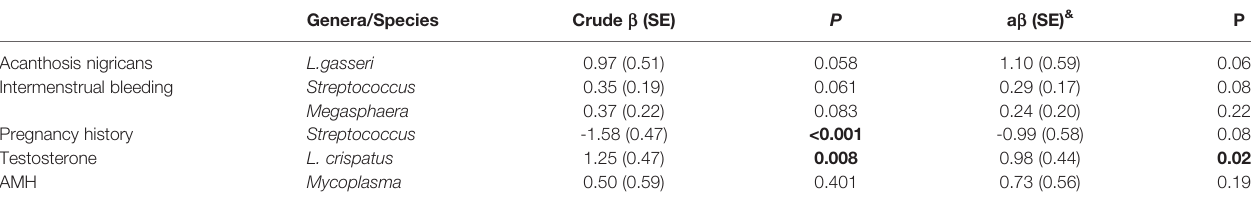
TABLE 4 | Potential biomarker constituents of the vaginal microbiota for clinical features and hormone levels of PCOS patients*.